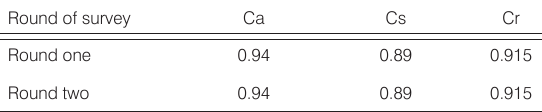
Table 6. Survey on the scope of practice of prescriptive authority for midwives in specific